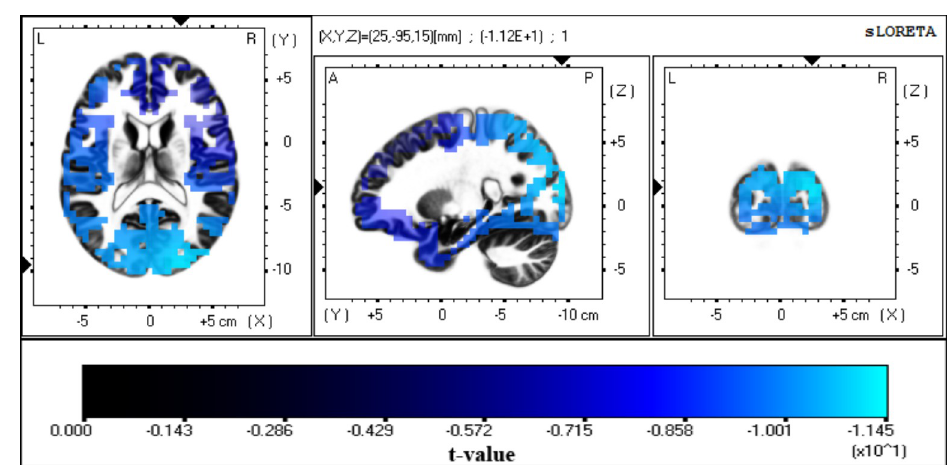
Fig 6. Source localization of visual alpha ERD. Images showing the anatomical estimation of unthresholded visual alpha ERD sources from the LORETA solution using paired t -tests with 5000 randomizations. A relatively large number of voxels were marked as significant, with the highest values being observed over the medial occipital gyrus and cuneus ( t -value < -5.77 = p < 0.001). Only the first 10 percent of voxels with the highest values were selected as an ROI for effective connectivity analysis (see text). ERD, event-related